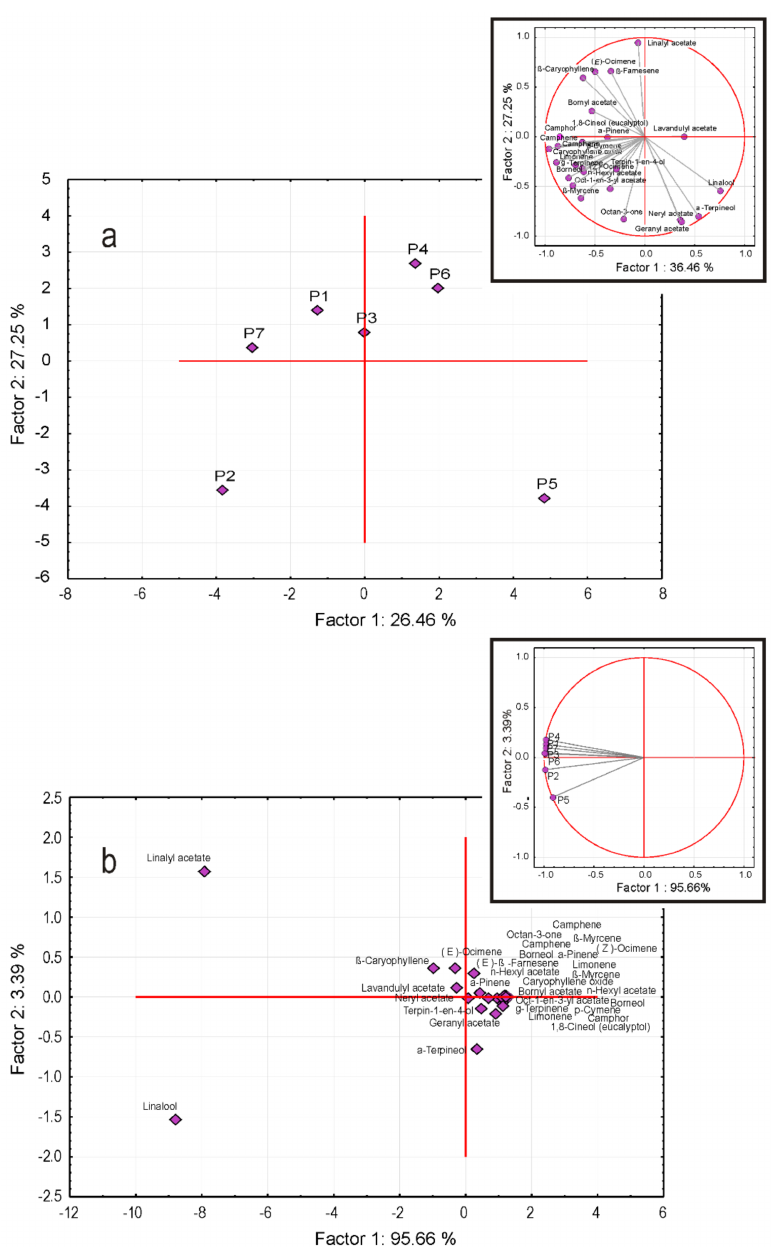
Figure 2. The results of R ( a ) and Q ( b ) mode PCA. The insets illustrate the contribution of the corresponding principal component (PC) analysis.